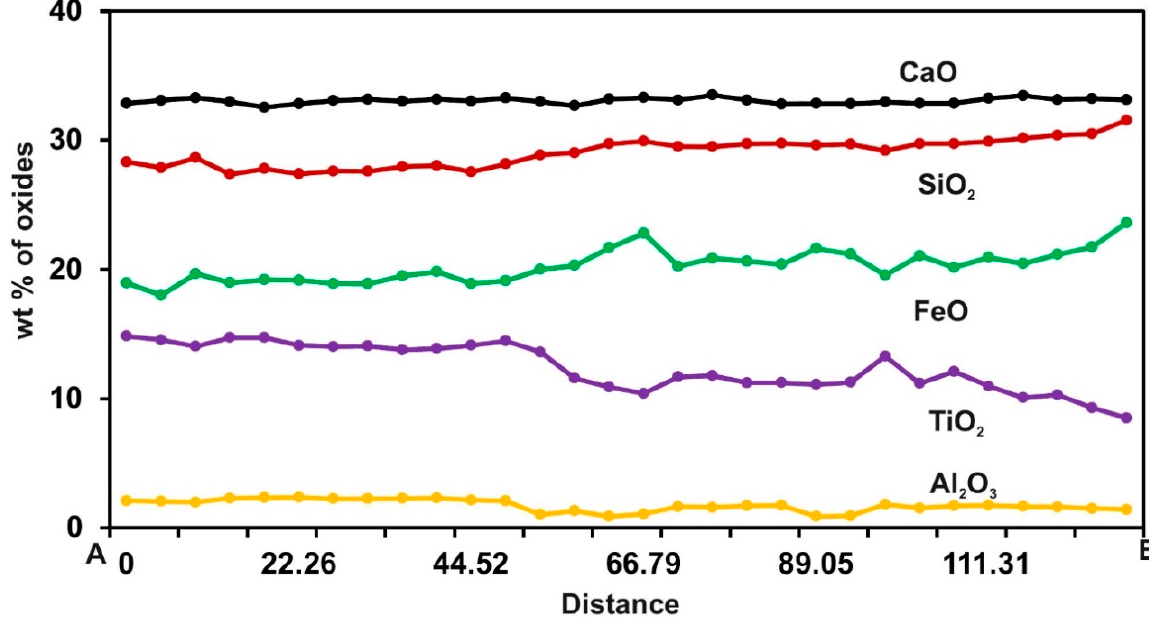
Figure 5. EPMA line scans along the line A–B (as shown in Figure 4a) for various oxides in the studied garnet grain.